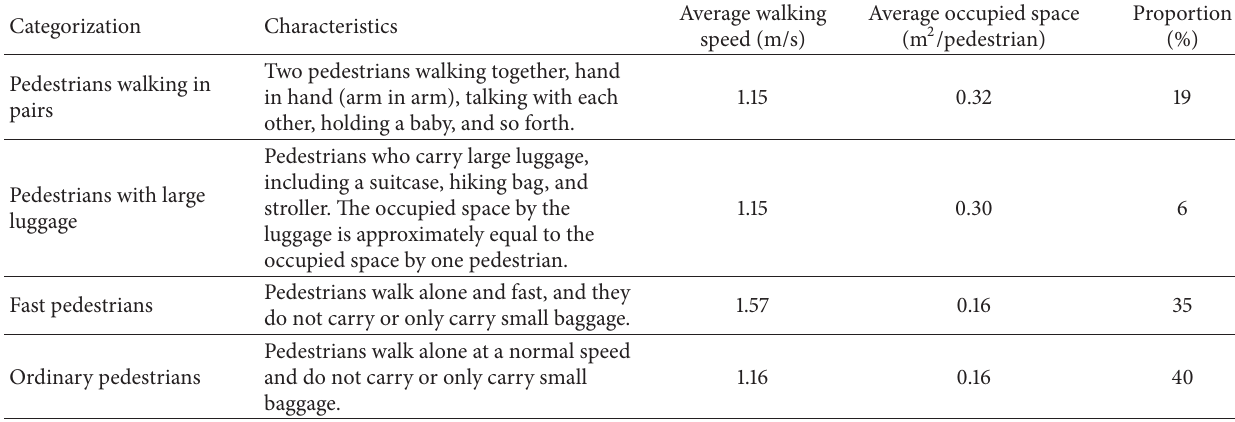
Table 1: Categorization of pedestrians.